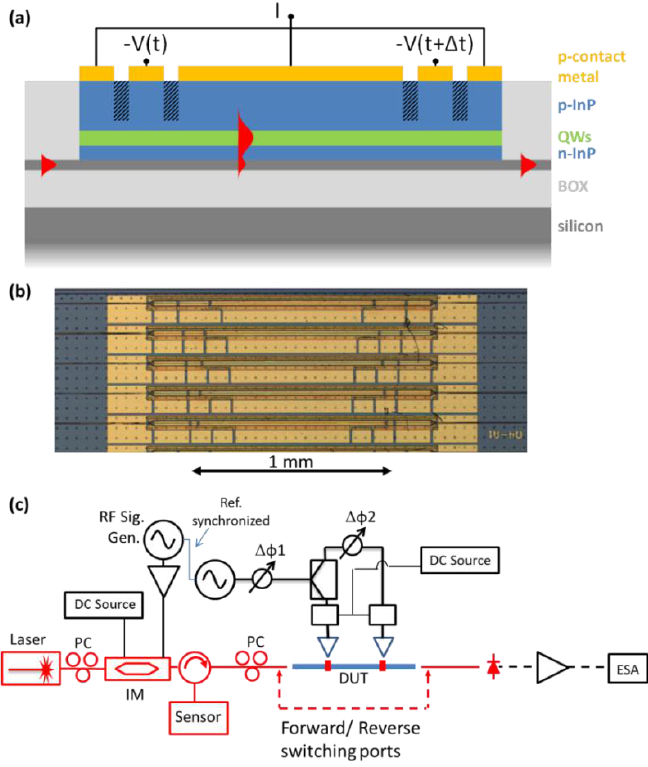
Figure 3. ( a ) Schematic of the hybrid silicon MWP isolator, showing the optical field